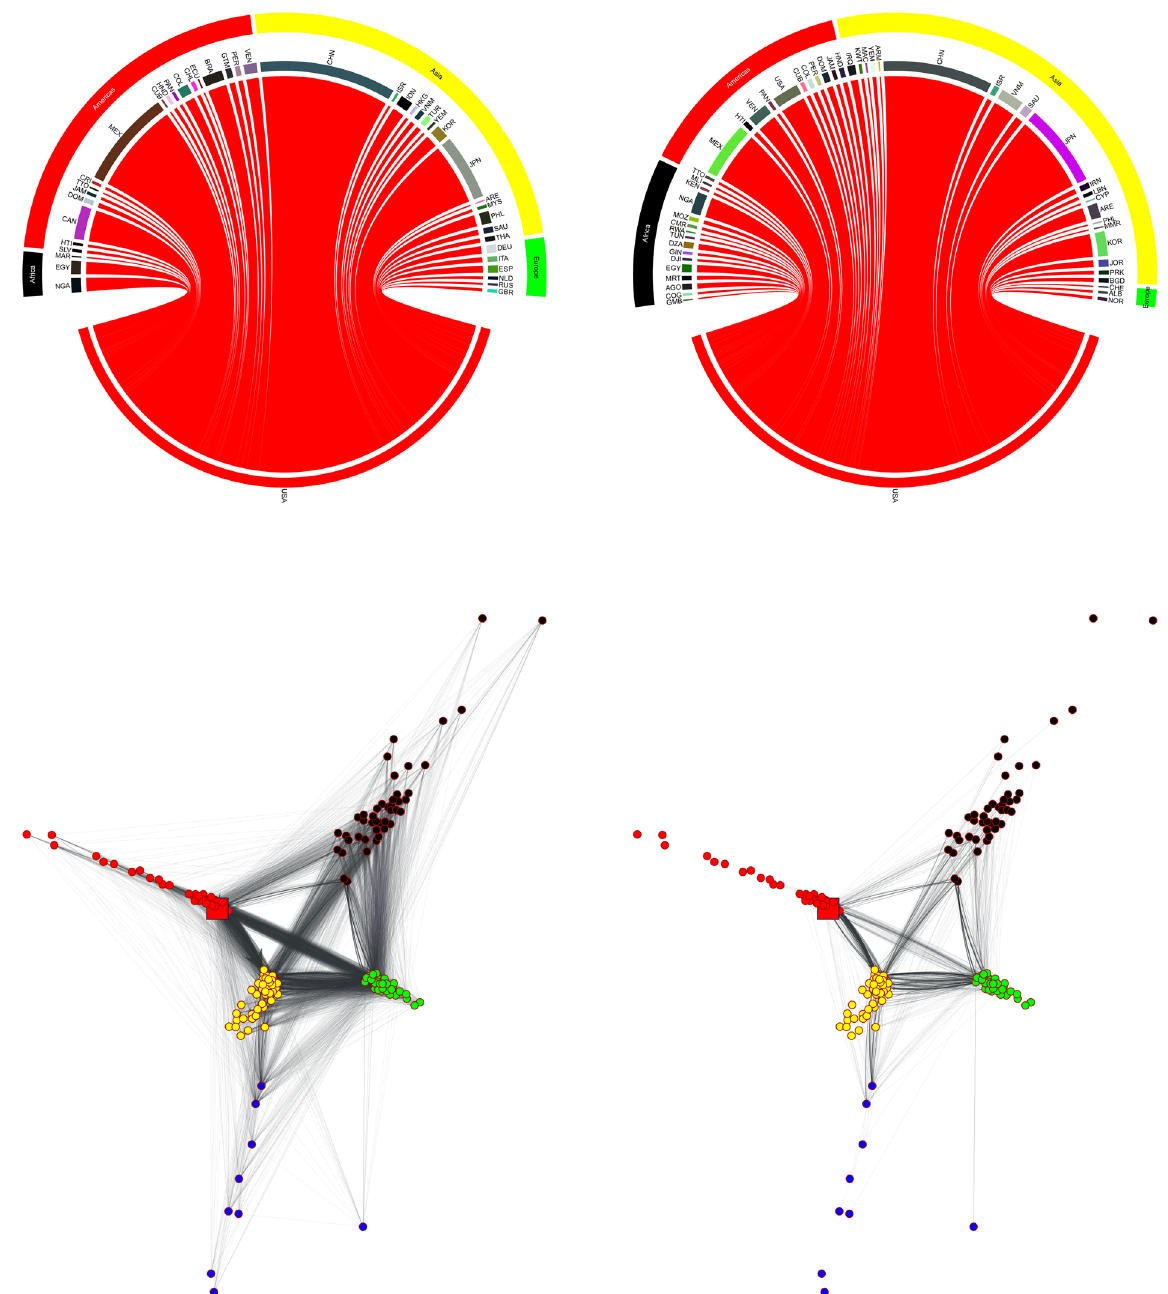
Figure 2. Diffusion of shock hitting the US: first (left panel) and last (right panel) step of the simulation. The two chord diagrams show, in absolute terms (kcals), how a simulated shock associated to a 30% reduction in US domestic food production propagates to the other countries of the network. In particular, the left panel reports the countries affected in the first step of the simulation, while the right panel reports the final distribution of the shock (i.e., at the end of the simulation). The diffusion of the shock is simulated setting α = 1 , but similar results can be obtained imposing α = 0.5 and α = 0 . Below the chord diagrams, the corresponding networks are shown. The color of the nodes represents the Country’s continent, and the mapping is the same as in the chords diagrams. The node marked by a square represents the